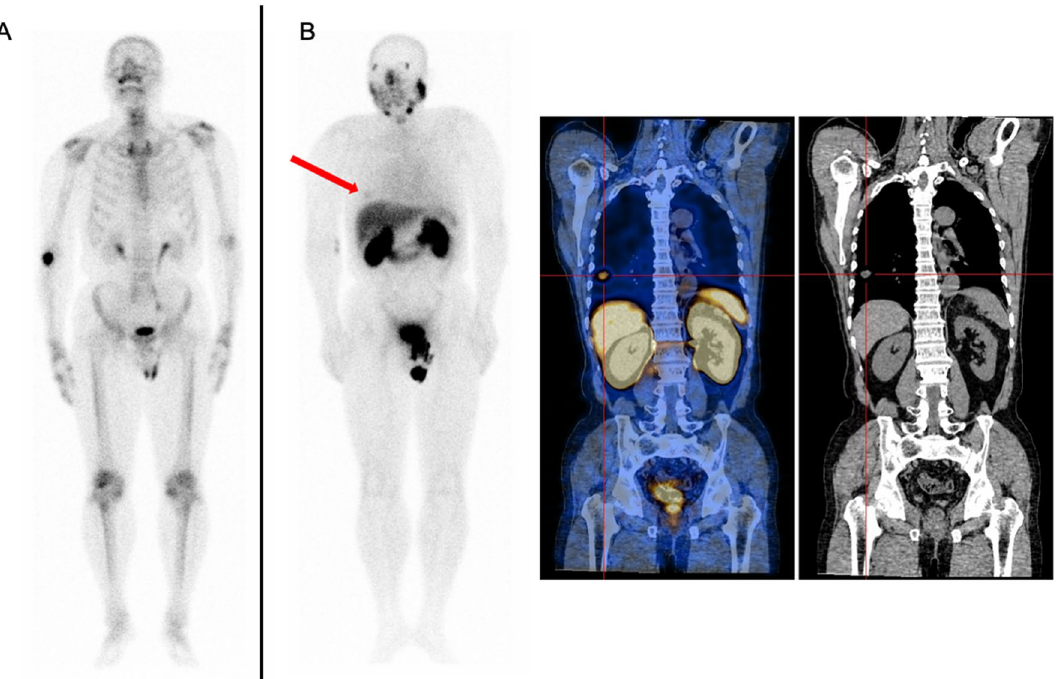
Figure 6. A 66-year-old patient with a BR of PCa. The Gleason score was 7, and the PSA level was 3.14 ng/mL. ( A ): Whole-body planar 99m Tc-MDP. ( B ): Whole-body planar 99m Tc-PSMA and coronal SPECT/CT. 99m Tc-PSMA SPECT/CT helped identify lung metastasis ( B , red arrow and cross).